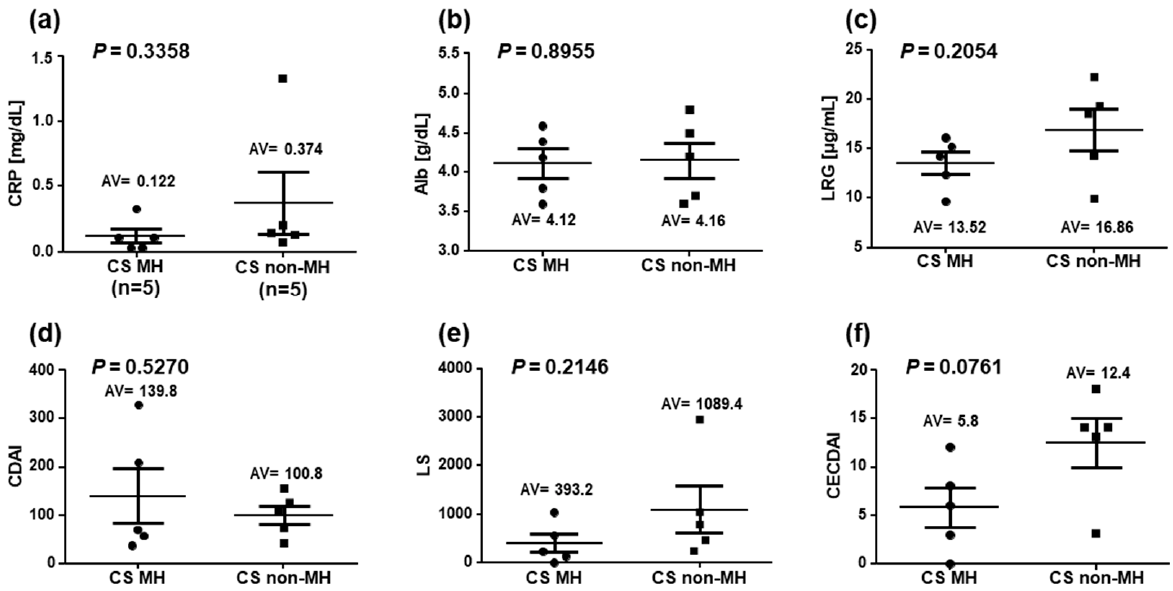
Figure 2. Connection between Crohn’s disease activity markers and mucosal healing in ileocolonoscopy. ( a ) CRP, ( b ) Alb, ( c ) LRG, ( d ) CDAI, ( e ) LS, and ( f ) CECDAI were determined in the CS-MH (n = 5) and CS-non-MH groups (n = 5); P - value is the result of comparing two groups by the two- tailed t -test. Abbreviations: CDAI: Crohn’s Disease Activity Index, Alb: blood albumin level, CRP: C-reactive protein, LRG: leucine-rich alpha-2 glycoprotein, LS: Lewis Score, CECDAI: Capsule En- doscopy Crohn’s Disease Activity Index, CS: ileocolonoscopy, MH: mucosal healing, CE: capsule endoscopy.